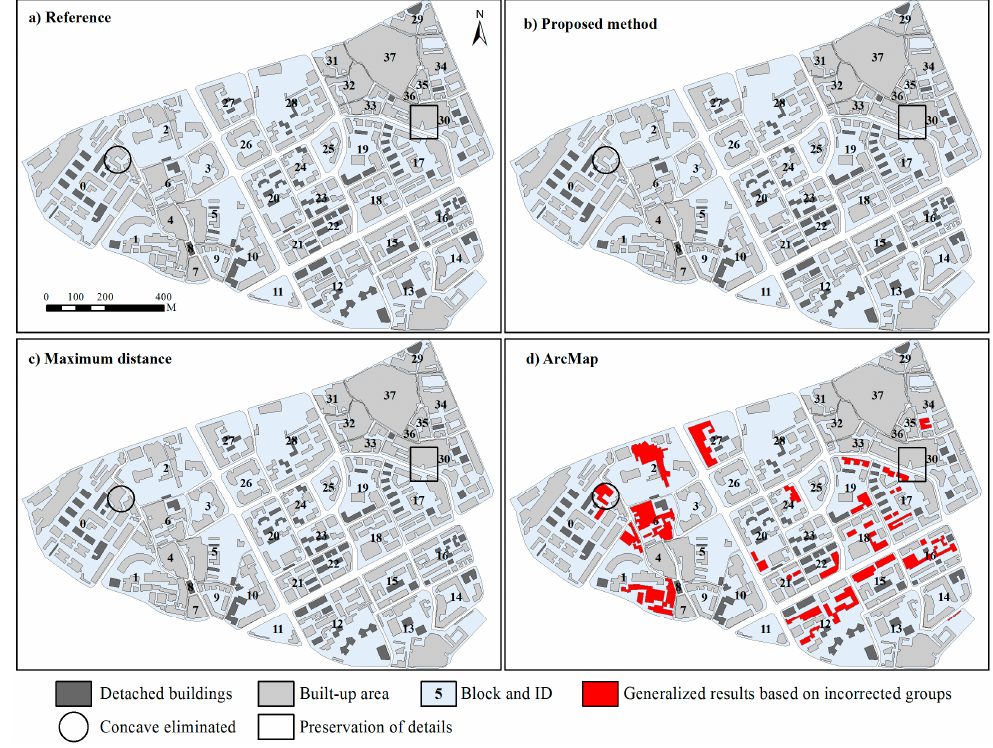
Figure 5. The same as Figure 4 with ID block, but generalized results are shown for ( a ) the proposed method; ( b ) Reference; ( c ) Max distance; and ( d ) ArcMap. Note that the displacement operation has been excluded from the experiment.